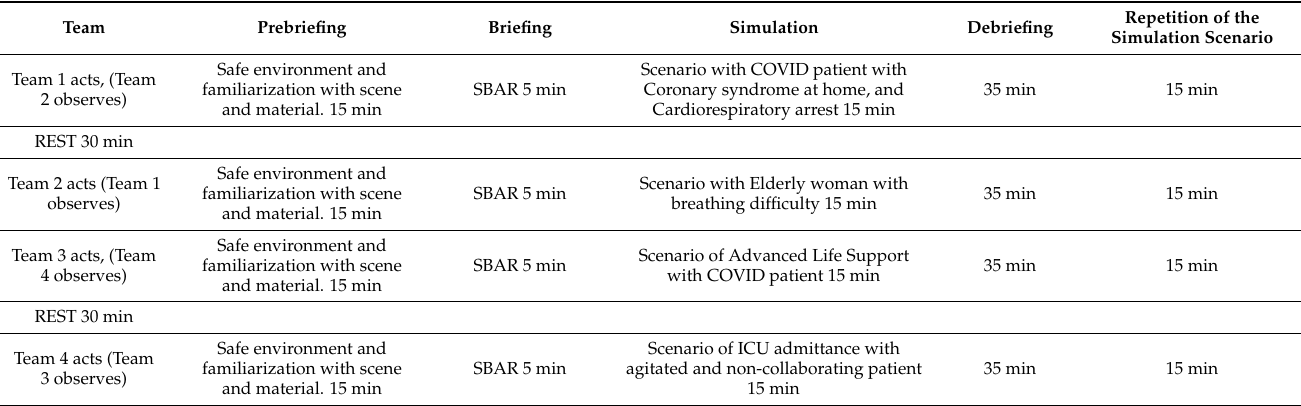
Table 3. Scenarios and procedures Phase 3 groups A (EMS) and B